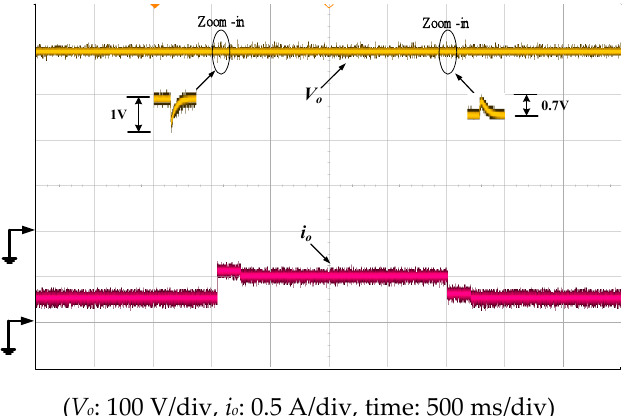
Figure 14. The voltage measurement of boosting capacitors C 1 and C 2 .